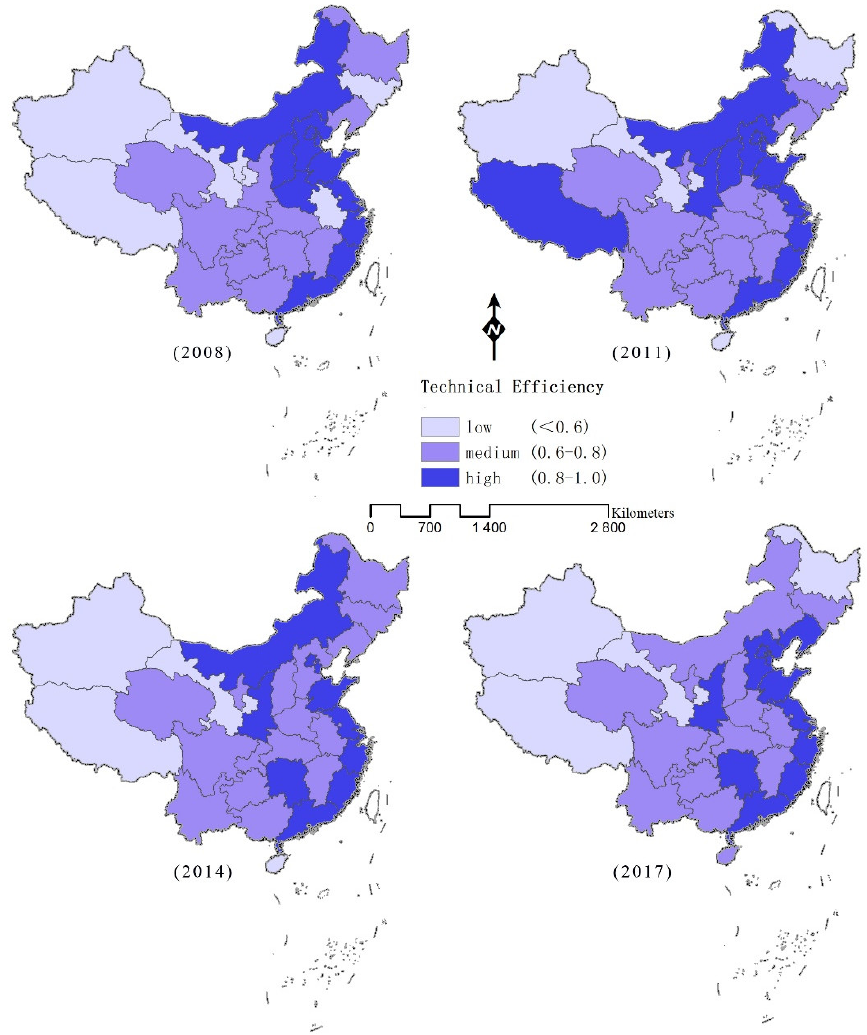
Figure 4. Spatial distribution of provincial urban land use efficiency in China.